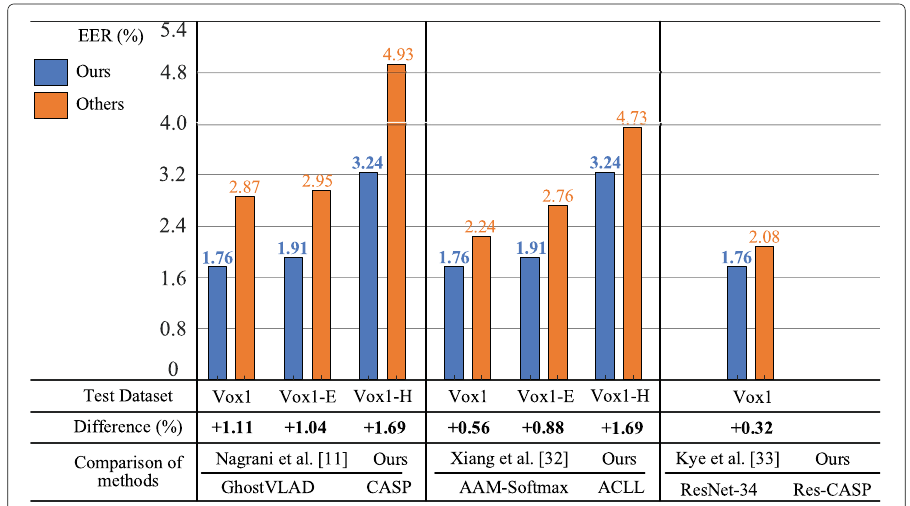
Fig. 8 Comparison with traditional